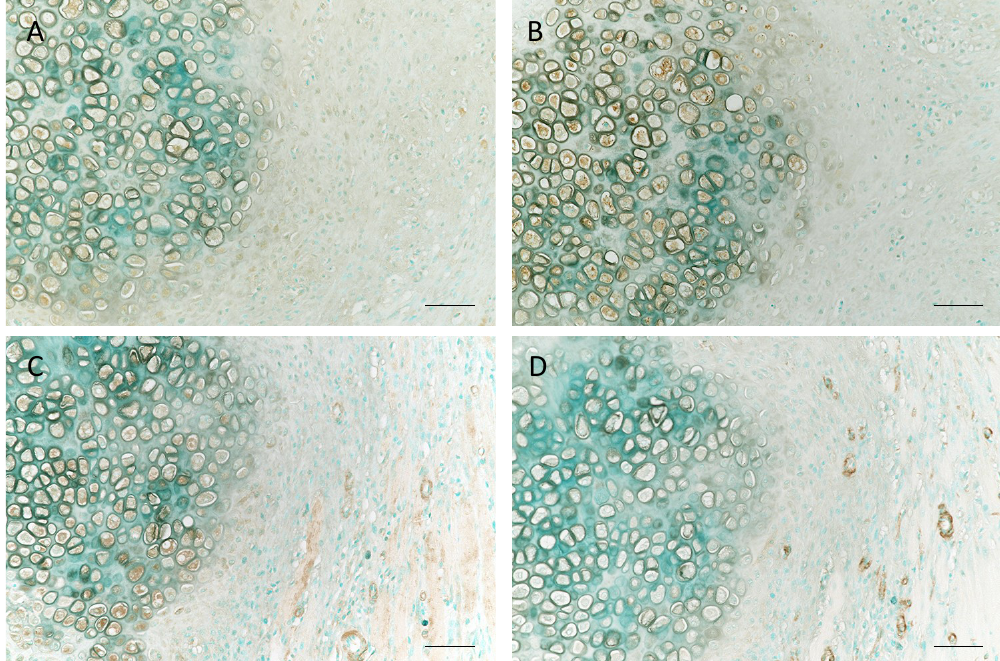
Figure 6. The localization of MMP-13, CCN2, p-p38 MAPK, and α -smooth muscle actin ( α -SMA) in fractured rat ribs at 7 days post-fracture. Sections stained with MMP-13 ( A ), CCN2 ( B ), p-p38 MAPK ( C ) α -SMA ( D ), and methyl green counterstaining of cartilage at day 7 post-fracture. Each right photo showing a histological section is a magnification of the rectangle-delimited area in the corresponding left photo. Bar, 50 μm.